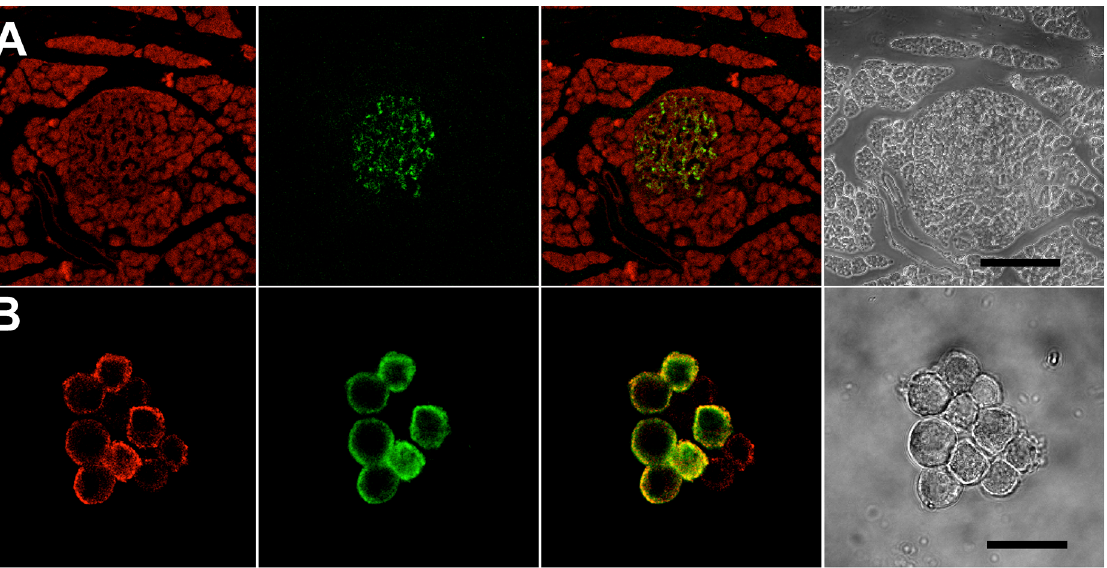
Fig 1. Localization of RyR2 in rat pancreas and rat pancreatic β -cells. (A) The panel shows a representative image of a rat pancreatic tissue section stained for RyR2 (red) and insulin (green) as a marker of pancreatic β -cells; overlapping of images at right shows the presence of both proteins in the center of the islet (islet of Langerhans). (B) The panel shows cells from a dispersed islet. Insulin staining is shown in green and RyR2 in red. Overlapping of images shows the presence of RyR2 in pancreatic β -cells as well as in other cell types of the islet. The calibration bars represent 200 μ m in (A), 20 μ m in